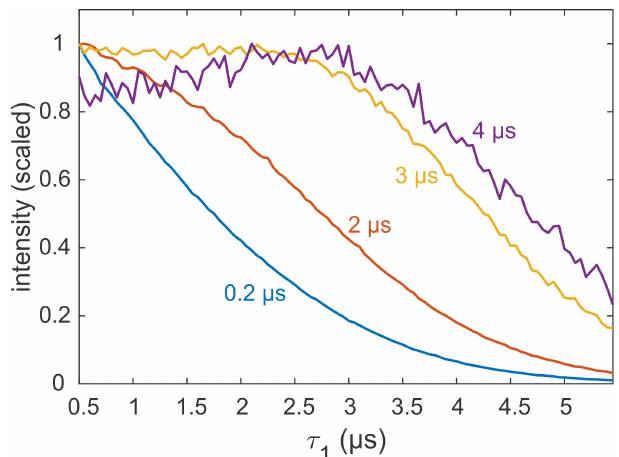
Figure 8. Refocused echo decay experiments (constant τ 2 ; variable τ 1 ) on 25µM MdfA V44C/V307C, doubly labelled with Gd-C2, at 10K. Selected values for τ 2 in nanoseconds are colour coded. Data taken from the Supplement of Yardeni et al.